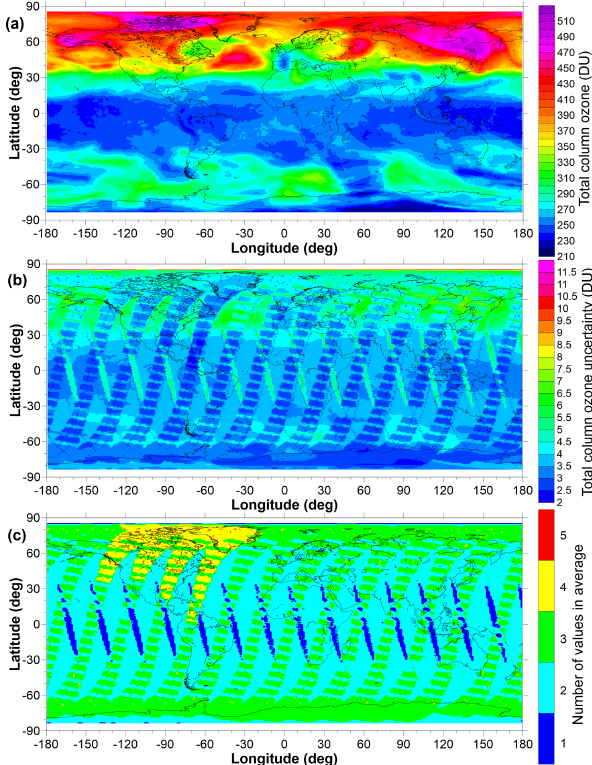
Figure 5. Example fields for 21 March 2005: (a) the TCO field, (b) the uncertainties on each value plotted in panel (a) , and (c) the number of values averaged to create the means plotted in panel (a) . Regions shaded in white denote the polar night where space-based measurements in the UV–visible part of the spectrum are not possi-